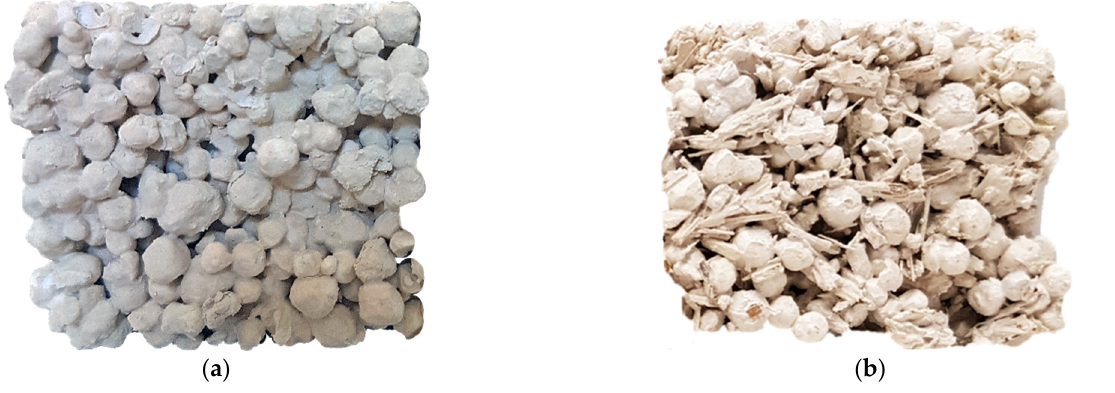
Figure 8. Samples of bonded leveling compound ( a ) CP 0 in Binder 1 ; ( b ) CP 30 in Binder 2